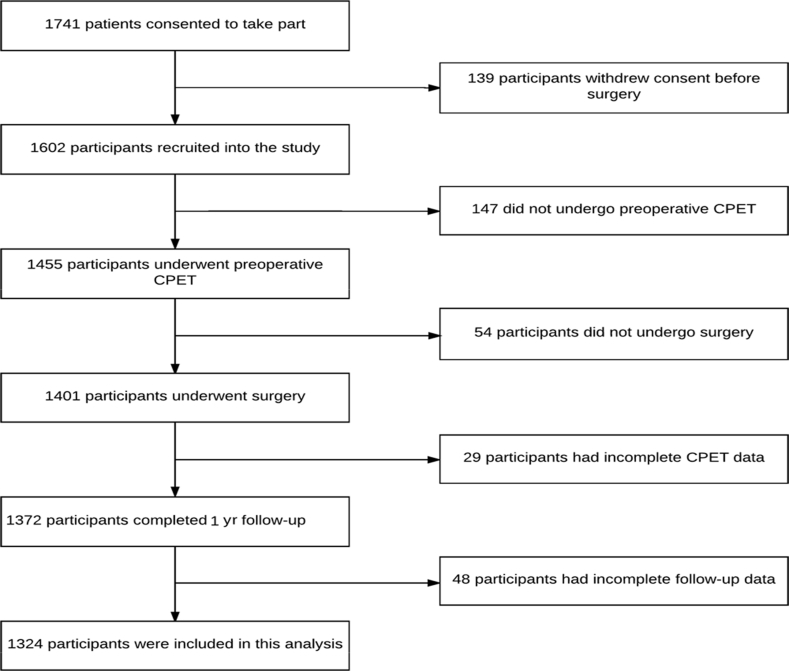
Patient flow diagram showing the number of cases included in the analysis. CPET, cardiopulmonary exercise testing.